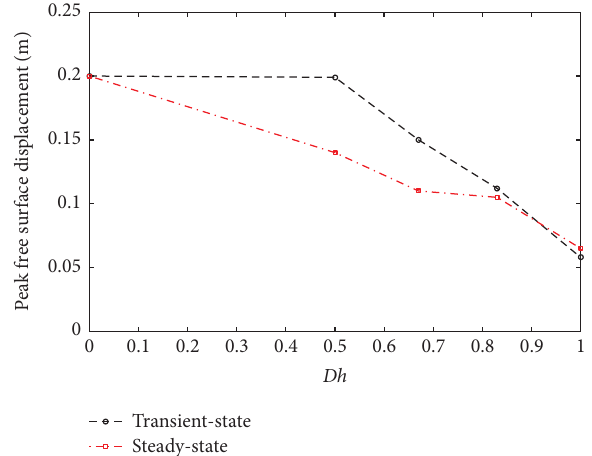
Figure 11: The peak free surface displacement response of coupled sloshing for different horizontal baffle